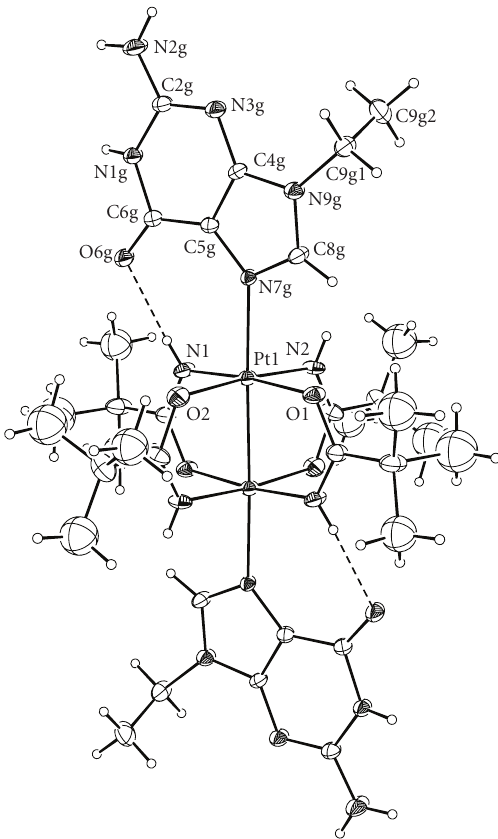
Figure 1: View of the [Pt 2 { HN = C(Bu t )O } 4 (9-EtG) 2 ] 2+ complex showing the atomic numbering scheme of most important